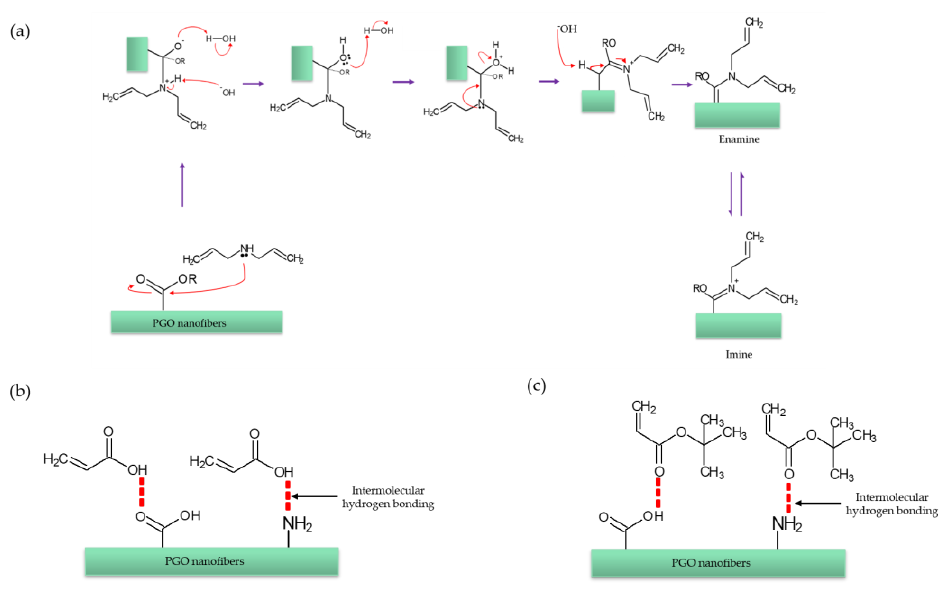
Figure 4. Interaction between monomers and nanofibers: ( a ) PGO-M1; ( b ) PGO-M2; ( c ) PGO-M3.